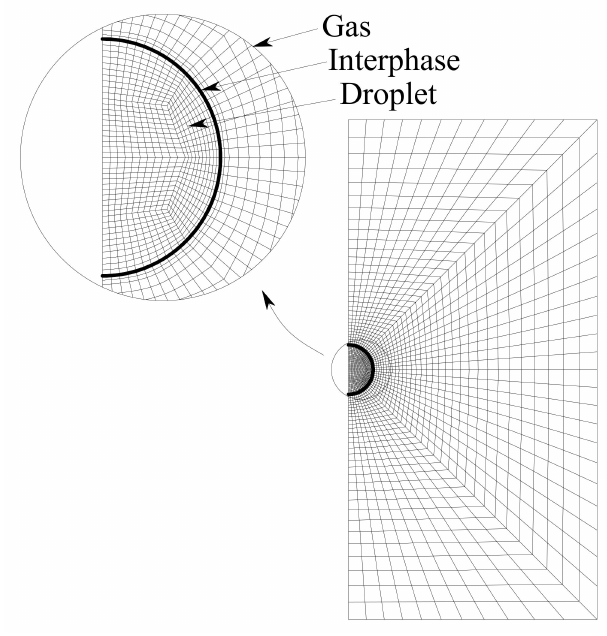
Figure 2. Computational